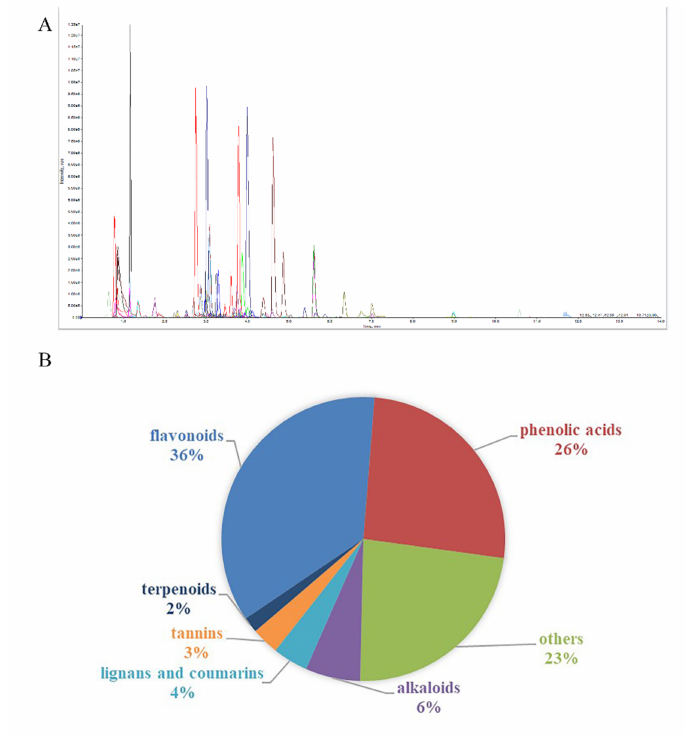
Figure 1. ( A ) The extracting ion current (XIC) chromatogram for the heart- and sapwood mix samples in a preliminary assay. ( B ) Types and proportions of differential secondary metabolites between heartwood and sapwood in the red-heart Chinese